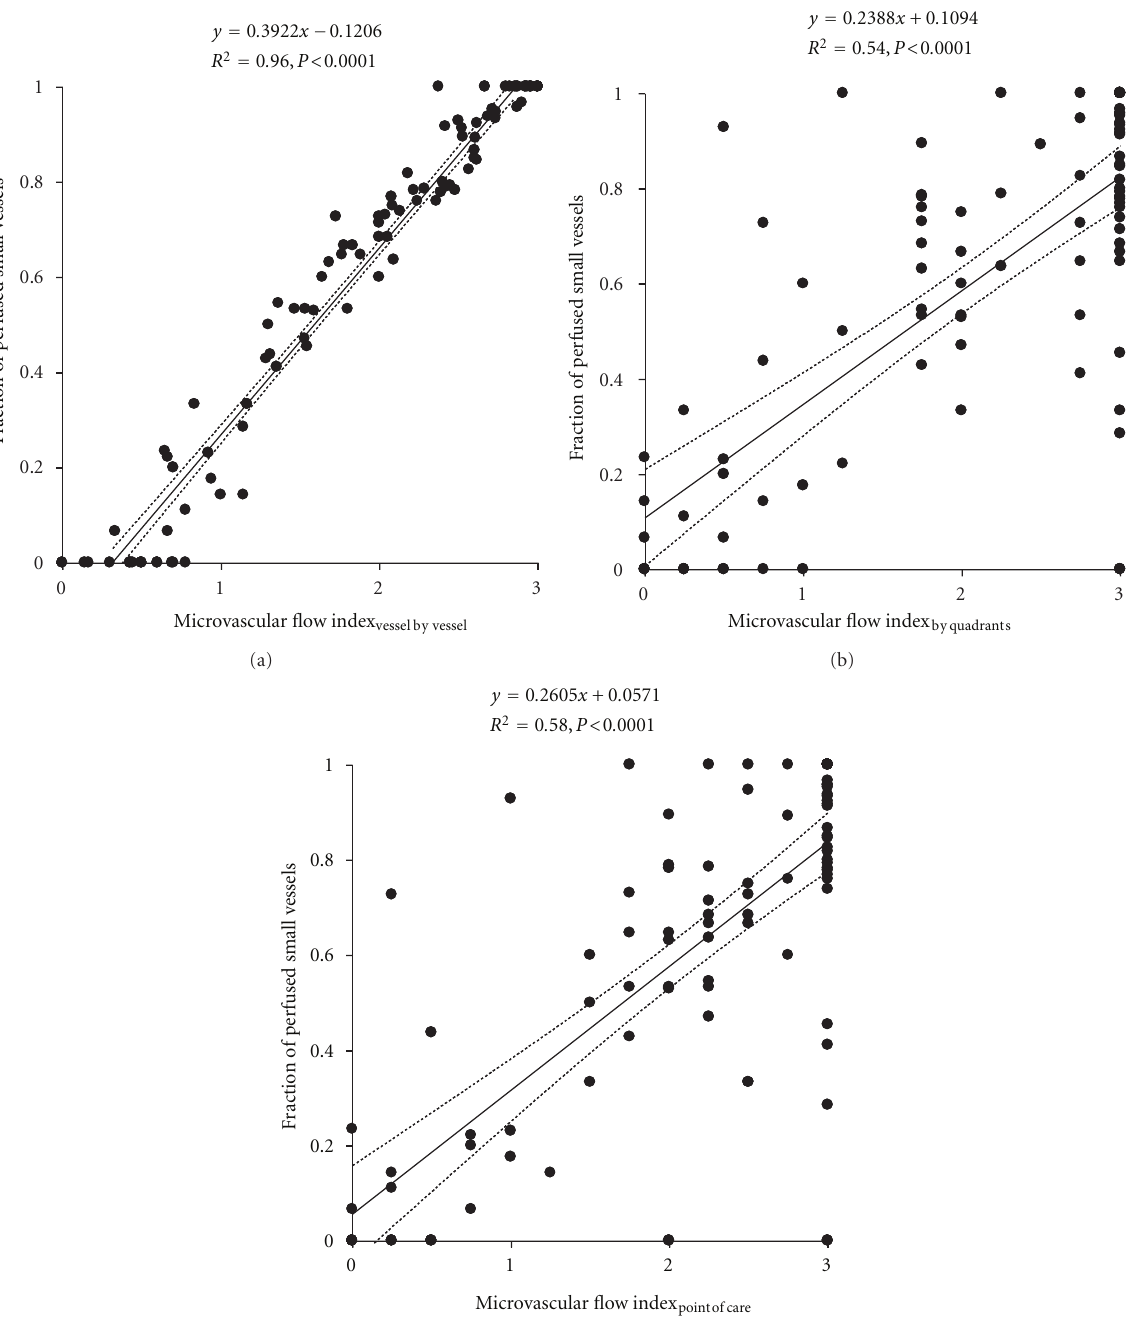
Figure 3: Correlations of the proportion of perfused small vessels with the microvascular flow index determined by vessel by vessel analysis (MFI vesselbyvessel ) Panel (a), the microvascular flow index determined by quadrants (MFI byquadrants ) Panel (b), and the bedside point-of-care microvascular flow index (MFI pointofcare ) Panel